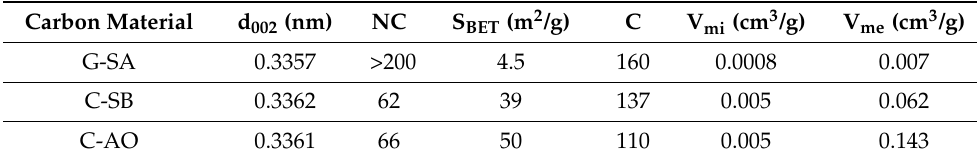
Table 1. Characteristics of structure and porosity of obtained carbon